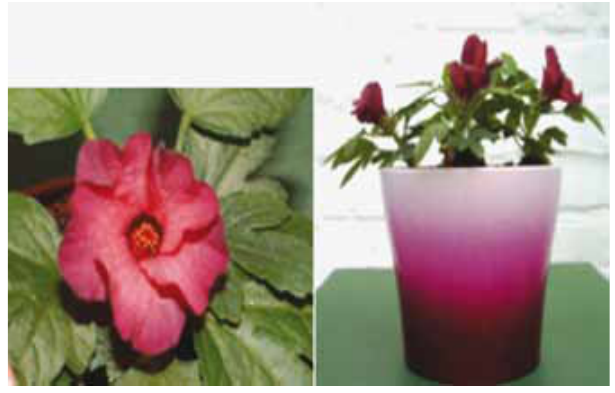
Figure 13: Definition of ornamental horticulture value of Brazilian ginseng